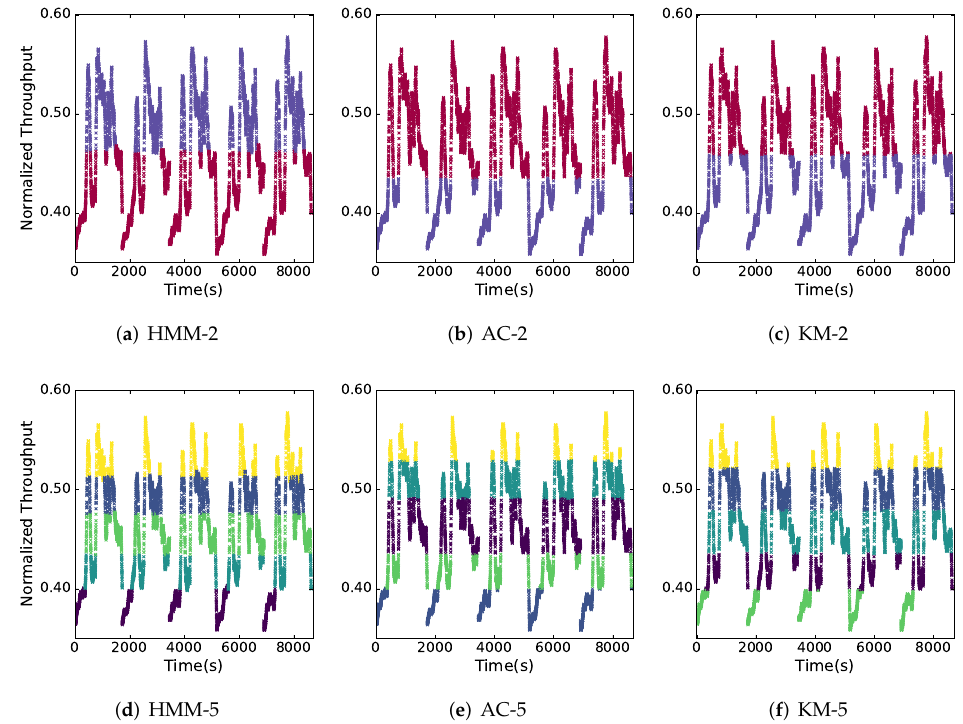
Figure 5. The result of one-step approach for state-mode identification on the dataset with no labels for work-cycles. Each state is distinguished by a different color. The first row shows the second-order model identification. The second row shows the results of the fifth-order model. The algorithms fail to capture the temporal dynamics of the signal where work-cycles are not identified and increasing the order only adds to the number of spatial